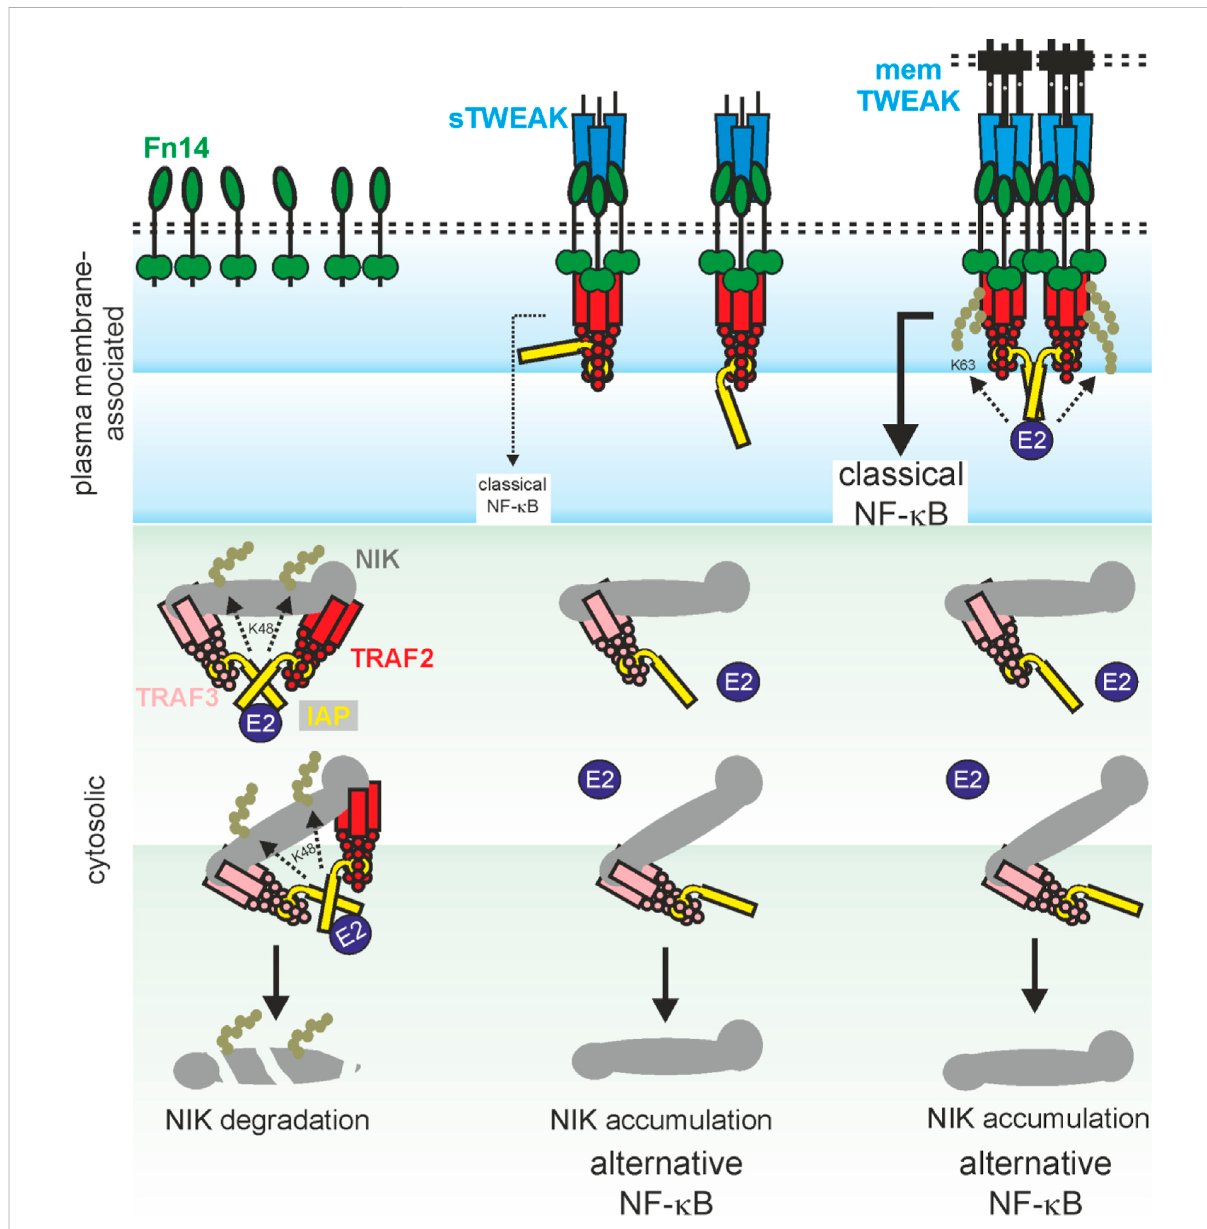
FIGURE 1 Model of TWEAK-induced NF- κ B signaling. Dependent on the interplay of sTWEAK, memTWEAK, Fn14, TRAF-cIAP1/2 and TRAF3-cIAP1/2-NIK complexes, three different states of NF κ B signaling can be distinguished: i) In the absence of TWEAK, TRAF3-cIAP1/2-NIK complexes interact with TRAF2-cIAP1/2 complexes in the cytoplasm. This results in cIAP1/2 transactivation and by help of E2 proteins to K48 ubiquitination of NIK by the cIAPs, proteasomal degradation of NIK and thus in constitutive inhibition of the alternative NF- κ B pathway (left panel). ii) In the presence of sTWEAK, ligated trimeric Fn14 complexes are formed which recruit a single TRAF2-cIAP1/2 complex and reduces so the availability of the latter for NIK degradation. As a consequence, there is reduced NIK degradation leading to accumulation of NIK and eventually to signal-induced alternative NF- κ B signaling. Since the Fn14-bound single TRAF2-cIAP1 and TRAF2-cIAP2 complexes remain largely inactive due to missing cIAP1/ 2 transactivation, there is no/poor classical NF κ B signaling (middle panel). iii) In the presence of memTWEAK, ligated trimeric Fn14 complexes are formed, too but due to their high concentrations in the cell-to-cell contact zone these complexes cluster secondarily leading to the recruitment of several TRAF2-cIAP1/2 complexes to the Fn14 clusters. Again, this reduces the availability of TRAF2-cIAPs complexes for NIK degradation and triggers the alternative NF- κ B pathway. However, since the Fn14-clusters bind several TRAF2-cIAP1/2 complexes, transactivation of cIAPs becomes possible leading eventually in classical NF κ B signaling (right